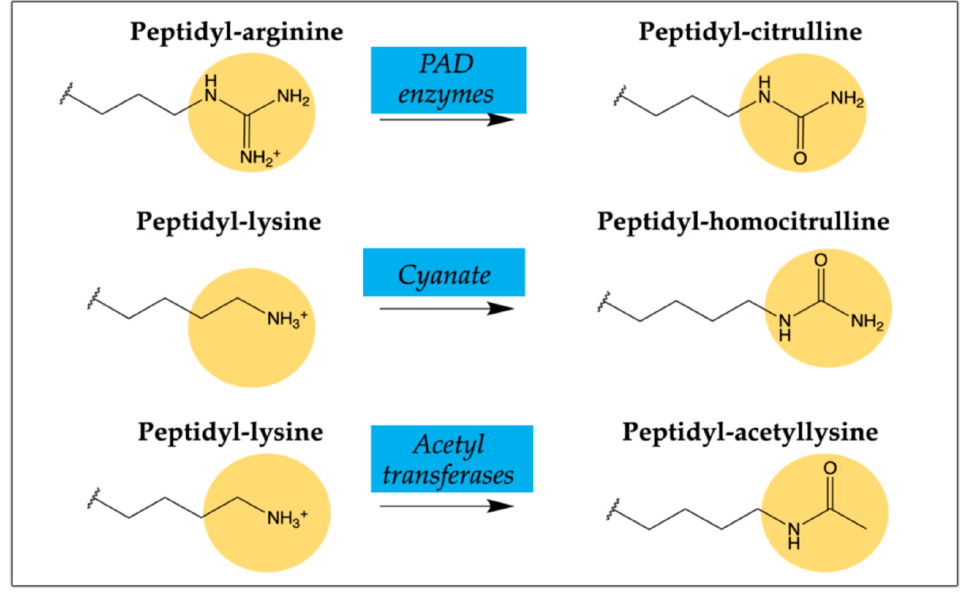
Figure 1. Schematics of post-translational peptide/protein modifications on arginine and lysine residues triggering AMPAs in RA patients.